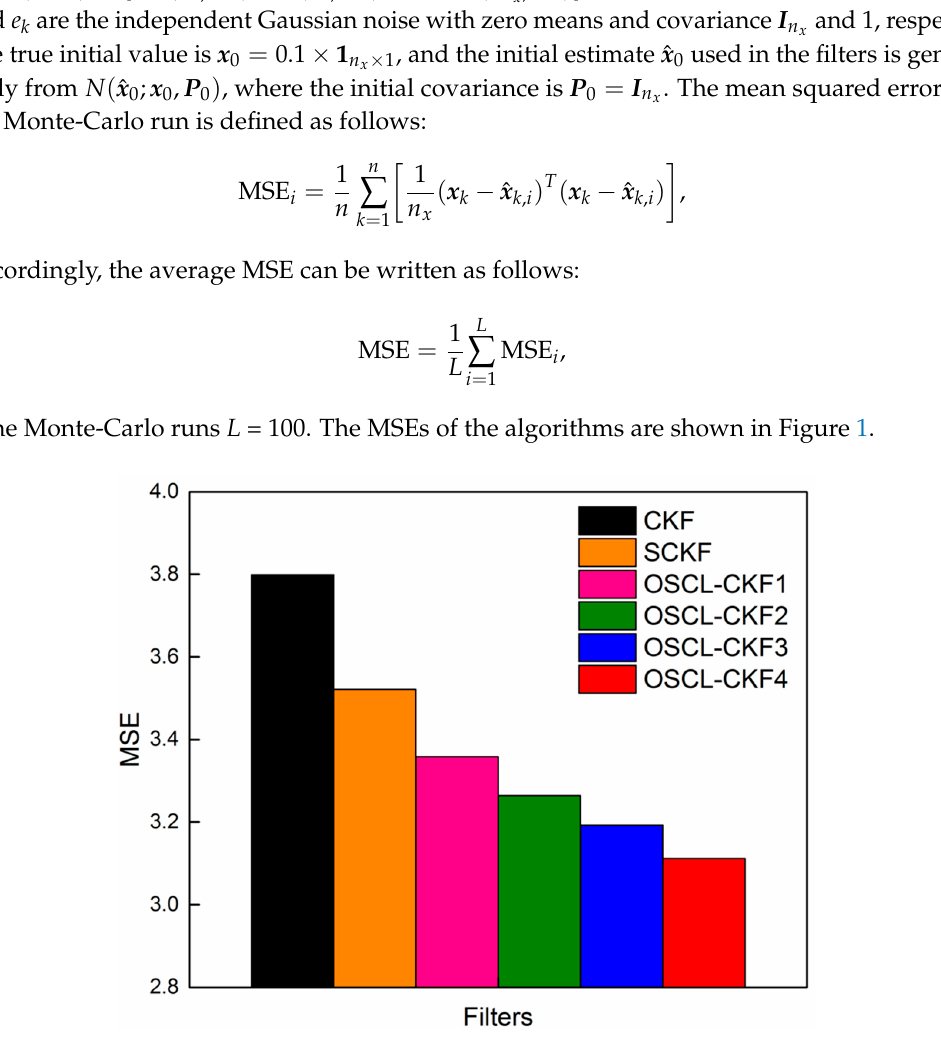
Figure 1. The mean squared errors (MSEs) of various algorithms. CKF—cubature Kalman filter; SCKF—simplex CKF; OSCL-CKF—orthogonal simplex Chebyshev-Laguerre CKF.